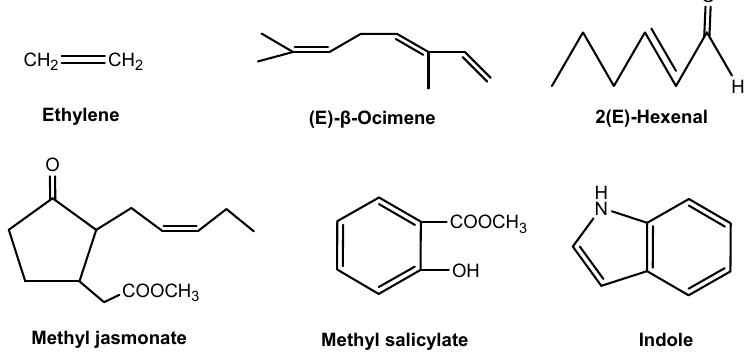
Figure 5. Plant-derived airborne signaling chemicals.